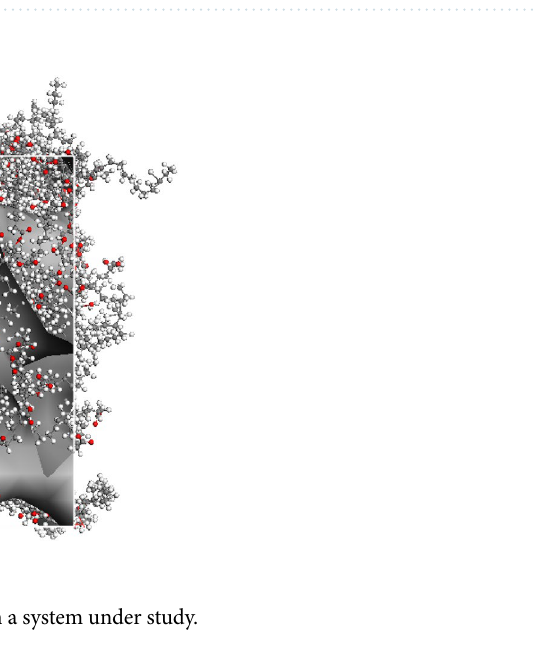
Table 1. RDF maxima between fullerene and different triglyceride atoms. C-Glycerine—carbon atoms of the glycerol backbone, O-Glycerine—oxygen atoms of the glycerol backbone, Ol-Chain—carbon atoms of the oleic acid residue, Pal-Chain—carbon atoms of palmitic acid residue, Ol-non-saturated—carbon atoms in the double bond of the oleic acid residue, O-Ol-Carbonyl—oxygen atoms in the carbonyl group of the oleic acid residue, O-Pal-Carbonyl—oxygen atoms in the carbonyl group of the palmitic acid residue.